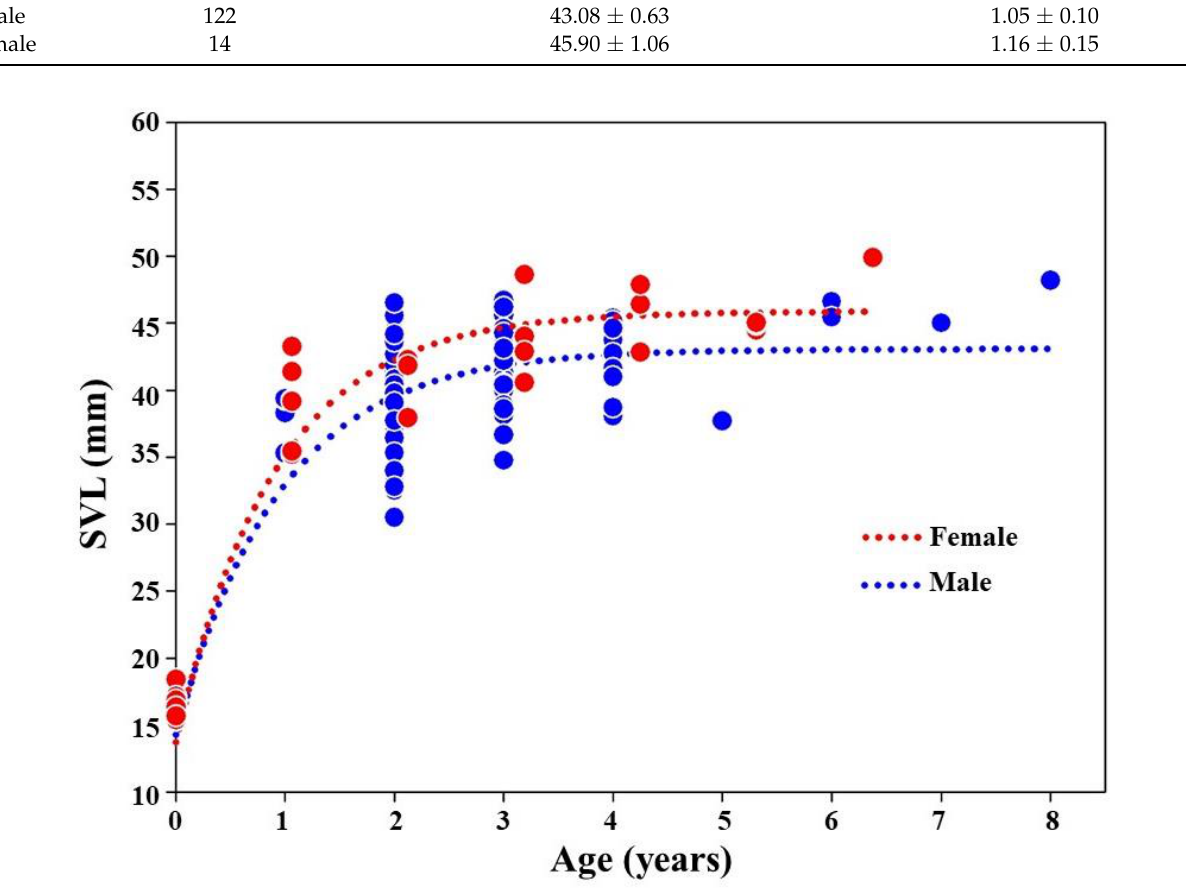
Figure 4. The growth curve for the adult K. borealis population at Lake Sihwa.